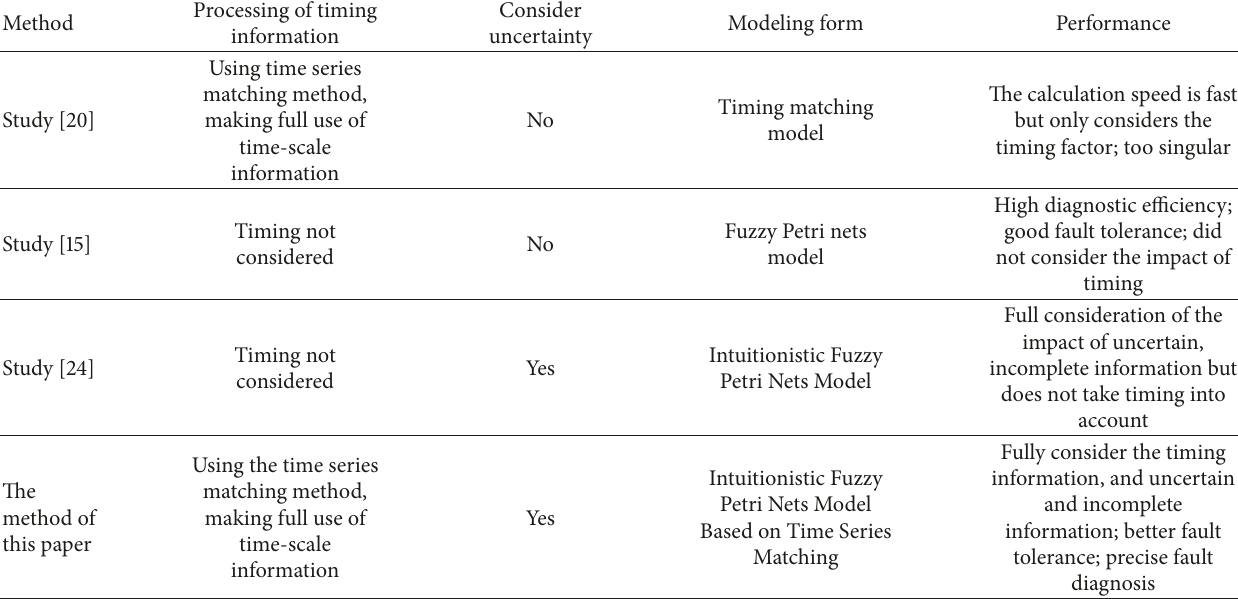
Table 3: Comparison of the proposed method and three existing methods for grid fault diagnosis.